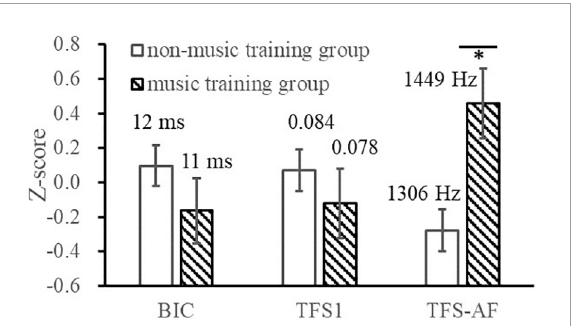
FIGURE6 Illustration of the BIC delay threshold and TFS sensitivities of the music training group and the non-music training group. ∗ p <